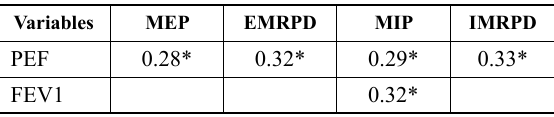
Table 2. Spearman’s correlations between respiratory pressure and spirometric variables